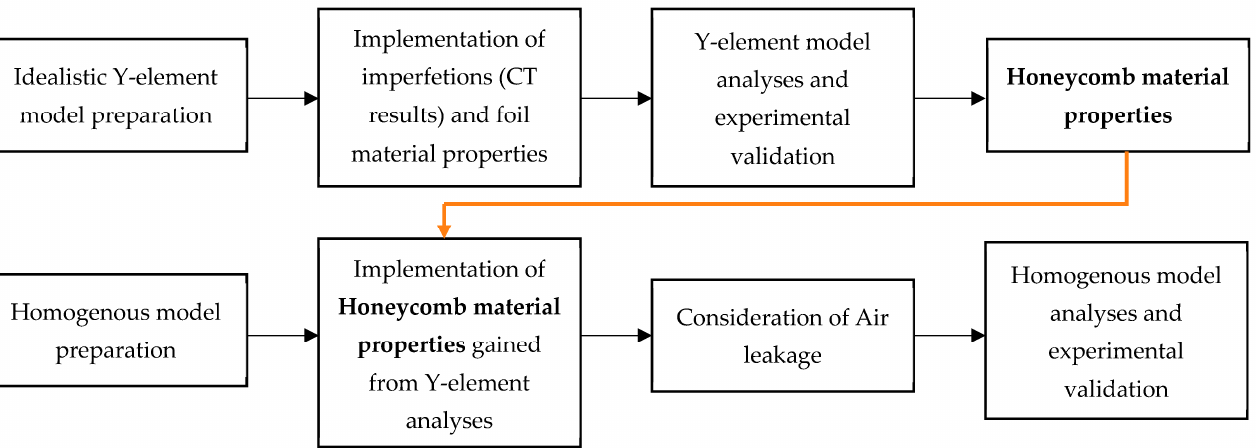
( c ) Figure 4. Y element: ( a ) geometric model, ( b ) finite element model, ( c ) boundary conditions. In order to accurately reproduce the actual structure and identify imperfections, the tested samples were subjected to computed tomography (CT) studies. A SkyScan 1174 tomograph was used for this task. The obtained point clouds were processed to reduce noise, and then they were used to generate a polygonised structure; discrete, triangular surfaces were created between the closest points. In this way, spatial models of the cores were obtained, which was useful for making measurements. The ax- onometric views of the CT models for the 1/8-0.0015 and 3/16-0.0015 samples are shown in Figure 5.